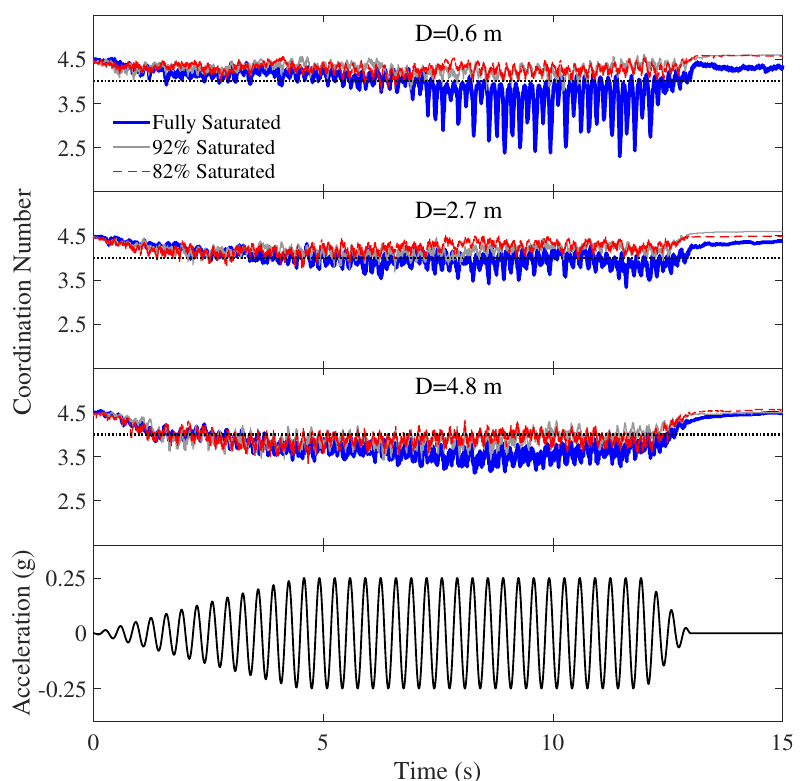
Figure 16. Time histories of the coordination number at selected depth locations for soil deposits with different degrees of